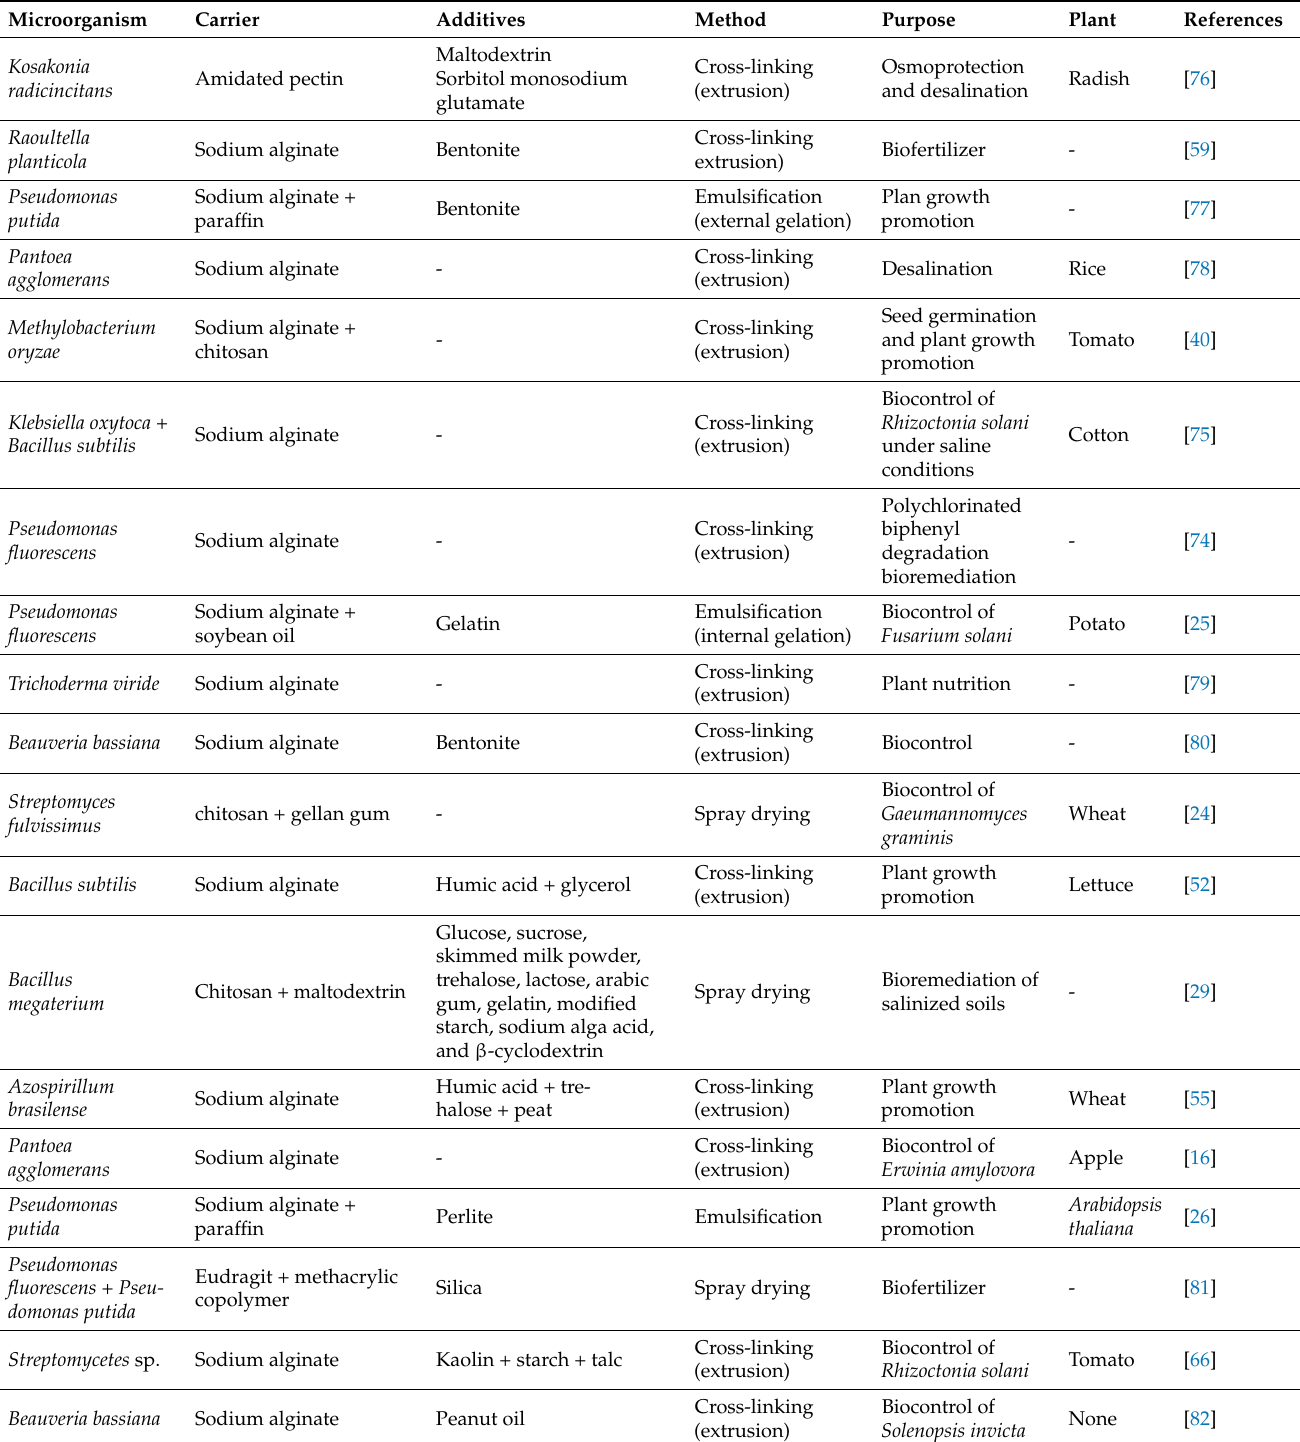
Table 1. Examples of characteristics of polymeric formulations of PGPM and their application